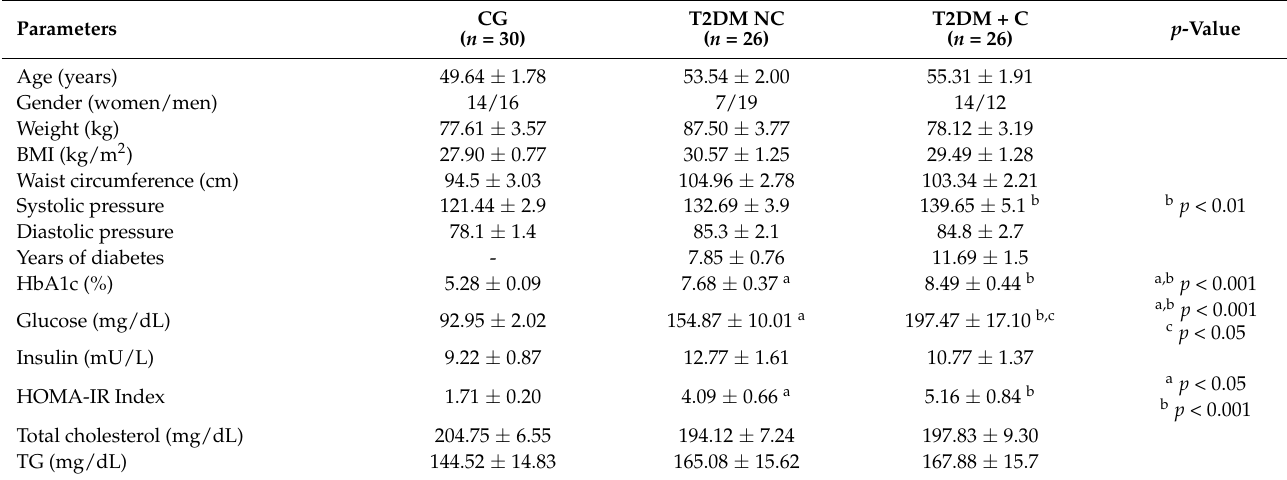
Table 1. Baseline characteristics and biochemical parameters of different groups of participants included in the